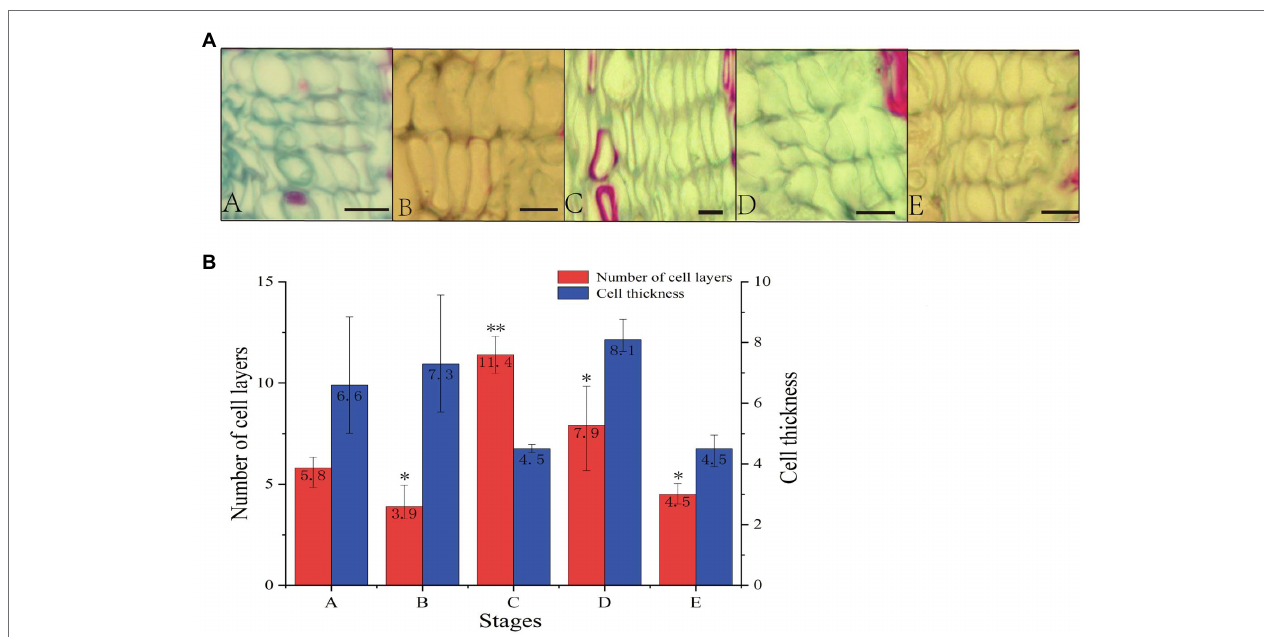
FIGURE 1 | (A) Cross section of stem segments of C. fortunei (A: April 20th, B: May 24th, C: June 15th, D: July 10th, E: September 15th; bar = 10 μ m). (B) Number of cell layers and cell thickness statistical analysis. The x-axis represents the different stages, and the y-axes on the left and right represent the number of cell layers and cell thickness, respectively; * p < 0.05, ** p <